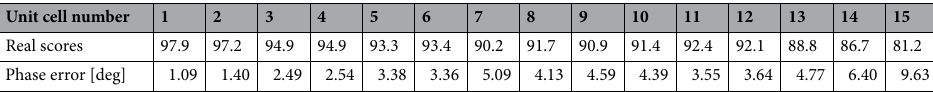
Table 1. Calculated real scores and phase errors for finalized unit